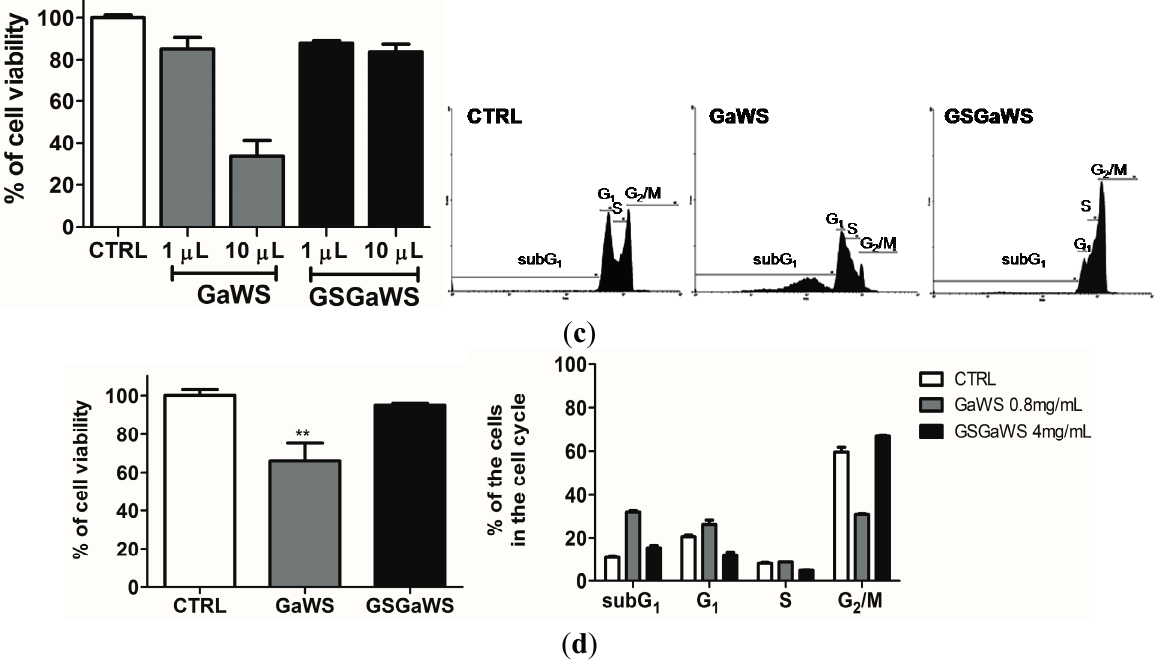
Figure 6. Dose-dependent inhibition of HuT 78 cell proliferation ( a ) after 24 h of treatment with cold and hot GaWS extracts and ( b ) after 24 h of treatment with cold GaWs and GSGa extracts. Trypan blue staining was used to differentiate viable cells. ( c ) The HuT 78 cell viability of untreated and treated cells with different concentrations (1 and 10 μ L) of GaWS and GSGaWS extracts after 24 h of treatment and FACS analyses; ( d ) antiproliferative effects of the GaWS (0.8 mg/mL) and GSGaWS (4 mg/mL) stored seven months at − 20 °C on HuT 78 cells and FACS analyses with the HuT 78 cell distribution at various stages of the cell cycle. p -values were 0.0112. ** p < 0.05, a significant antiproliferative effect with respect to the control using one-way